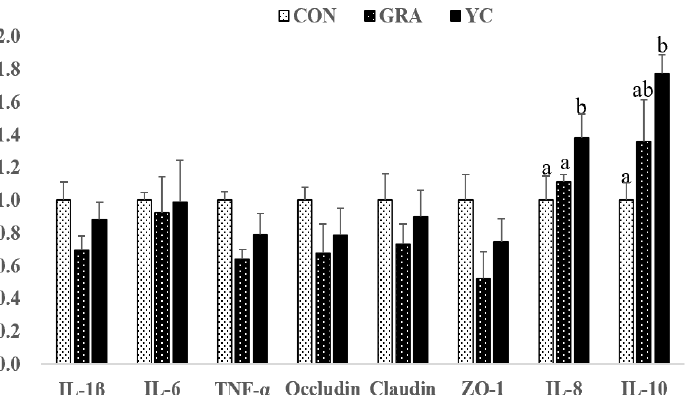
Figure 3. Effect of yeast culture supplementation on the mRNA levels of immunity-related genes in jejuna of finishing pigs. IL-10, interleukin 10; TNF- α , tumor necrosis factor- α ; IL-1 β , interleukin-1 β ; IL-6, interleukin-6; IL-8, interleukin-8; ZO-1, zonula occludens-1. Values are means and SEMs, n = 6 per group. a,b p < 0.05 between different superscripts within the same gene.